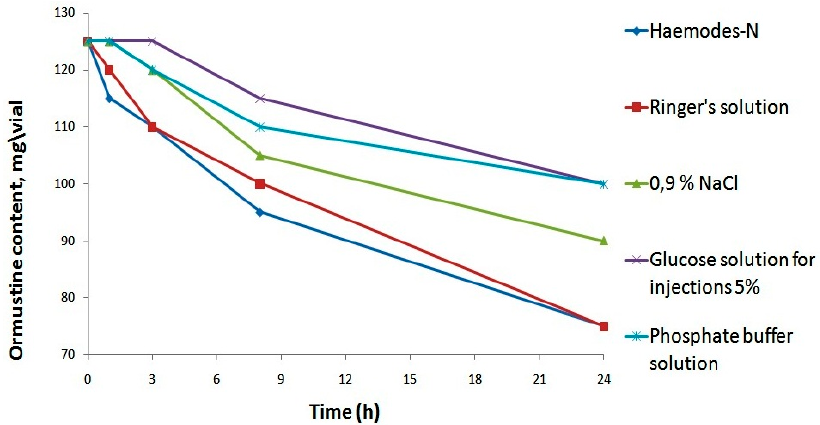
Figure 3. Stability studyof ormustine in PF after rehydration in various solvents.